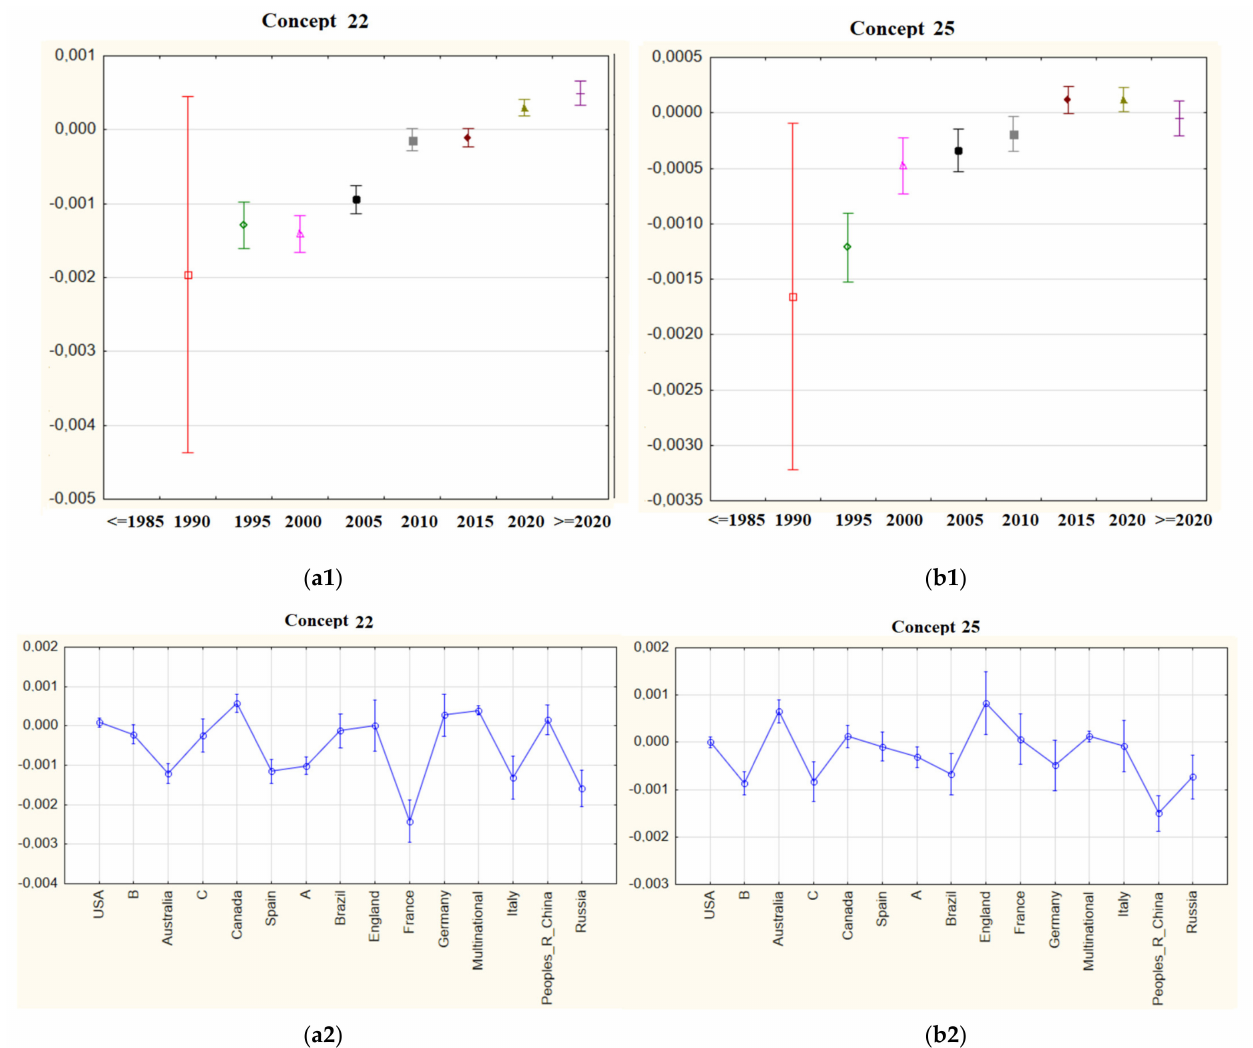
Figure 19. ( a1 ) mean importance weights of Concept 22 for five-year periods; ( b1 ) mean importance weights of Concept 25 for five-year periods; ( a2 ) mean importance weights of Concept 22 via countries; ( b2 ) mean importance weights of Concept 25 via